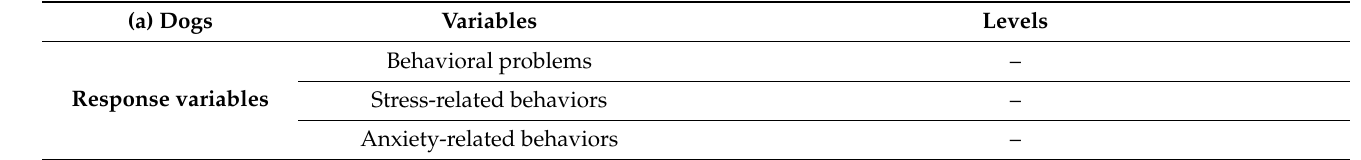
Table 2. Variables included in linear mixed-effects models (LMMs) for dogs (a) and cats (b). (a)